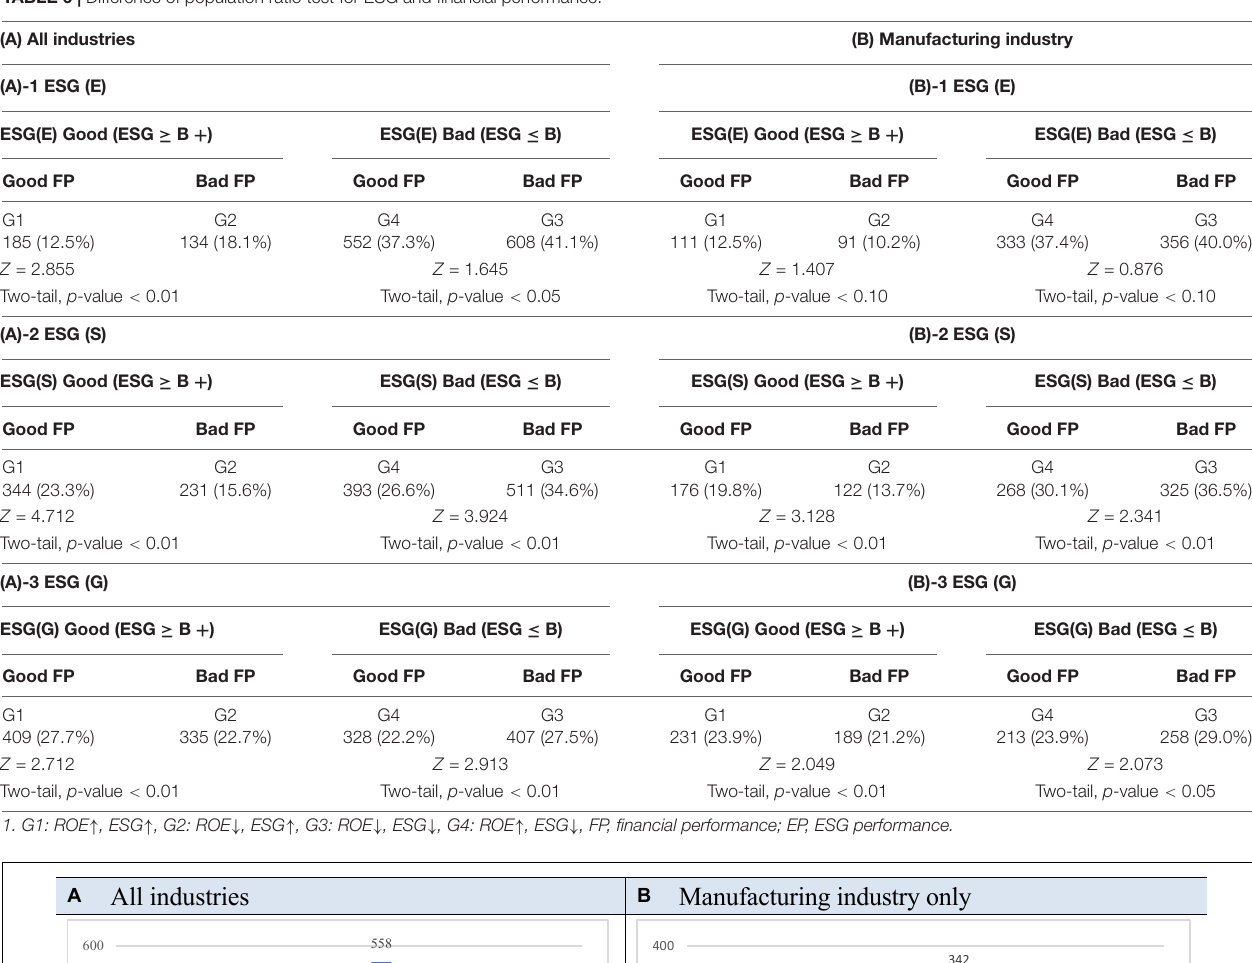
TABLE 6 | Difference of population ratio test for ESG and financial performance.